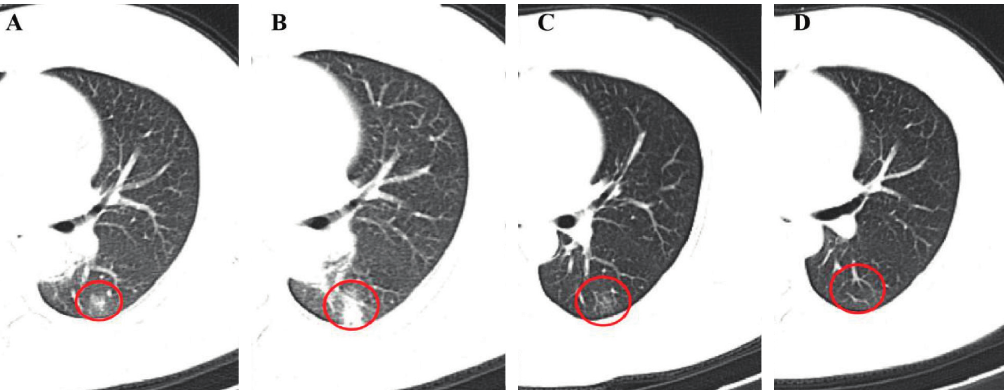
Figure 5: A 46-year-old female COVID-19 patient. On the initial CT (2 days after the initial symptom onset), the patchy GGO was shown in the left lower lung lobe (a) (red circle), but the lesion progressed to large opacities after approximate 5 days, with more lung tissues involvement (b). After regular treatment in hospital, the majority of the lesion was absorbed and dissipated (14 days), with little linear fibrotic lesions left (c). The lesion was absorbed completely on day 22